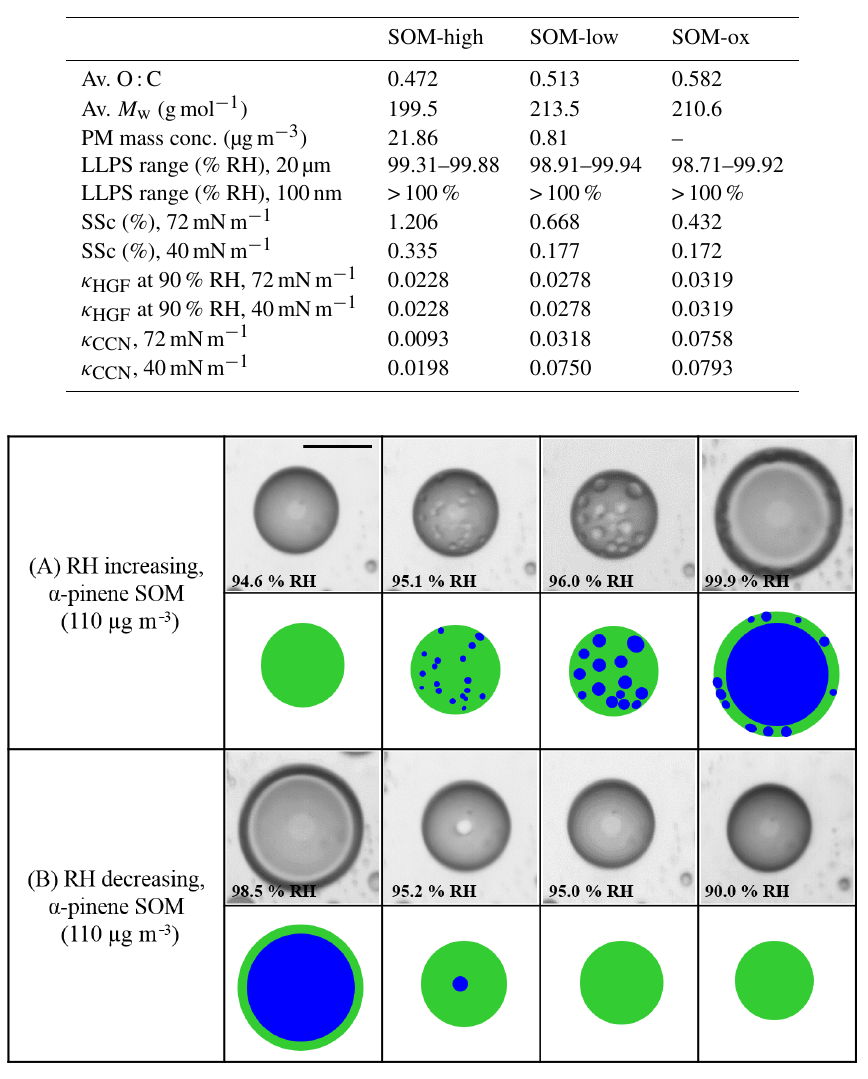
Figure 1. Effect of RH cycles on α -pinene-derived SOM for SOM produced at 110µgm − 3 . Illustrations of the images are shown for clarity. Green: SOM-rich phase. Blue: water-rich phase. Size bar is